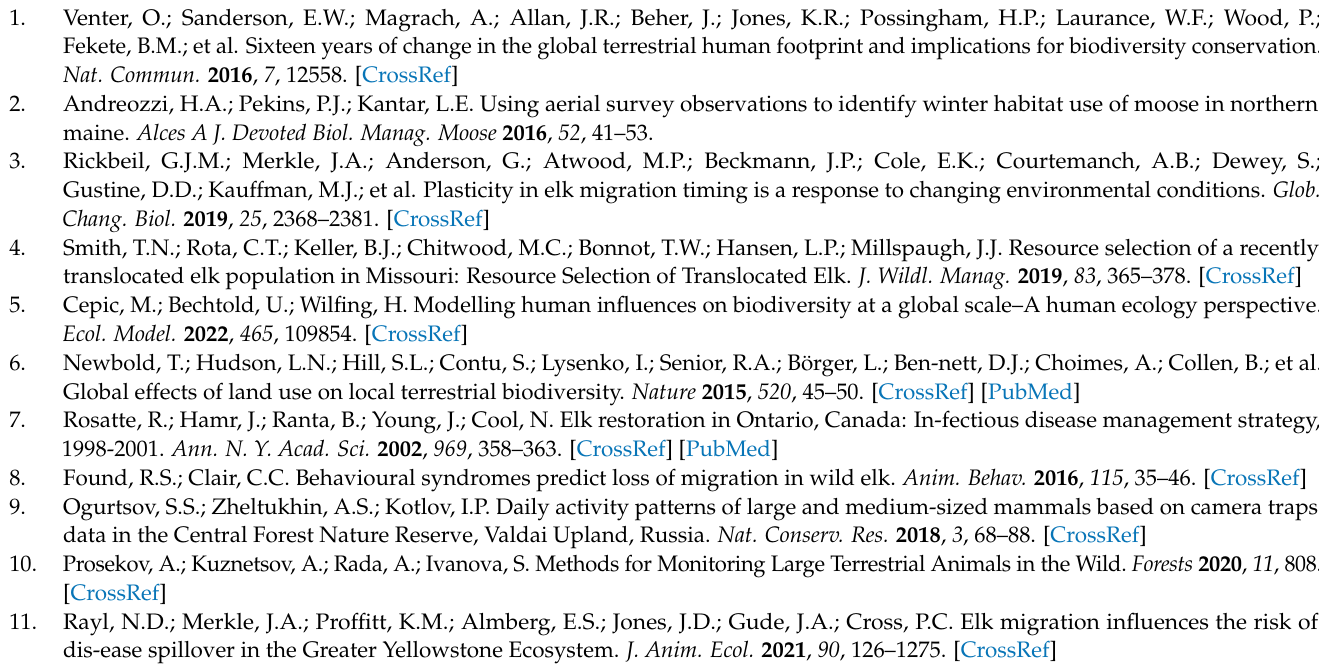
Figure S5: An example of untargeted objects (fishermen); Figure S6: Snapshot where visual inspection revealed two wolves (red circles at the bottom) and an elk (red circle at the top); Table S1: Coordinates of elks detected in 2019 (WGS 84); Table S2: Coordinates of elks detected in 2020 (WGS